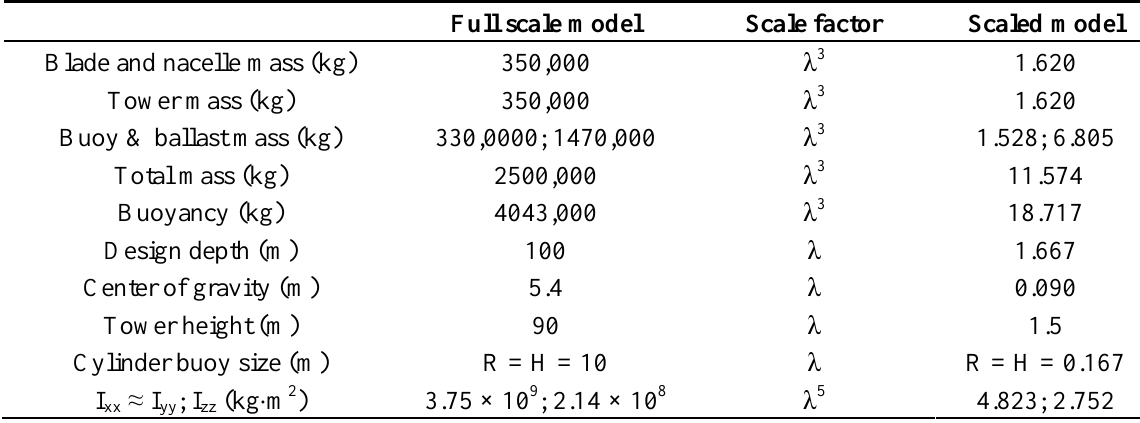
Table 1. The main design parameters of the scaled test model.